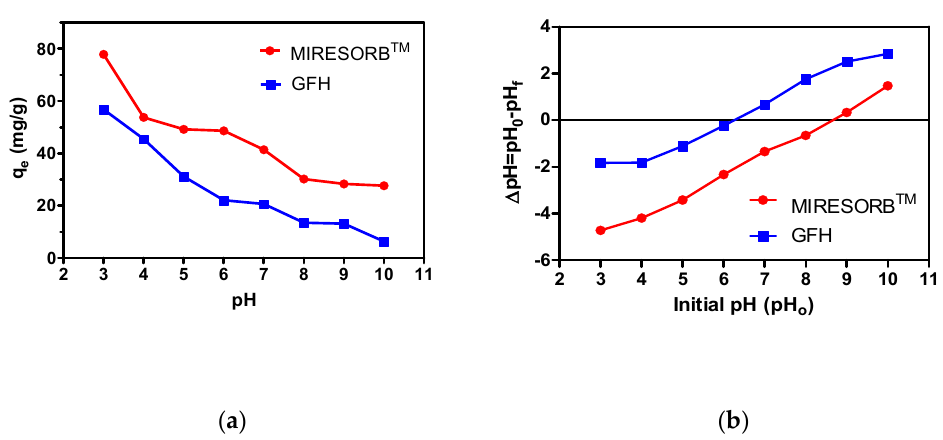
Figure 5. ( a ) Influence of pH on the arsenic adsorption capacity of MIRESORB TM and GFH materials. The initial As(V) concentration was 30 mg/L, the adsorbent dose was 0.5 g/L, the contact time was 48 h. ( b ) Point-of-zero charge determi- nation for the MIRESORB TM and GFH materials.